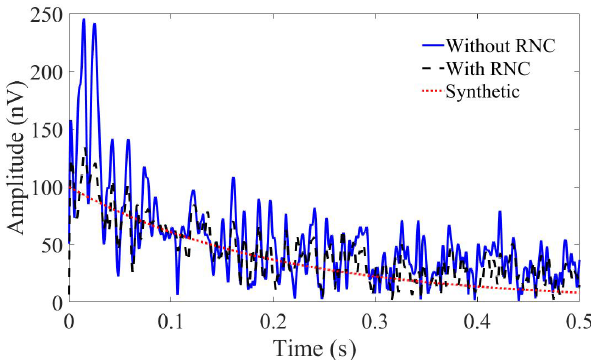
Figure 8. Envelopes extracted with and without RNC technique to demonstrate the SNR improvements of RNC. The red dotted line is the synthetic envelope. The blue solid line and black dashed line are the results processed without and with RNC.